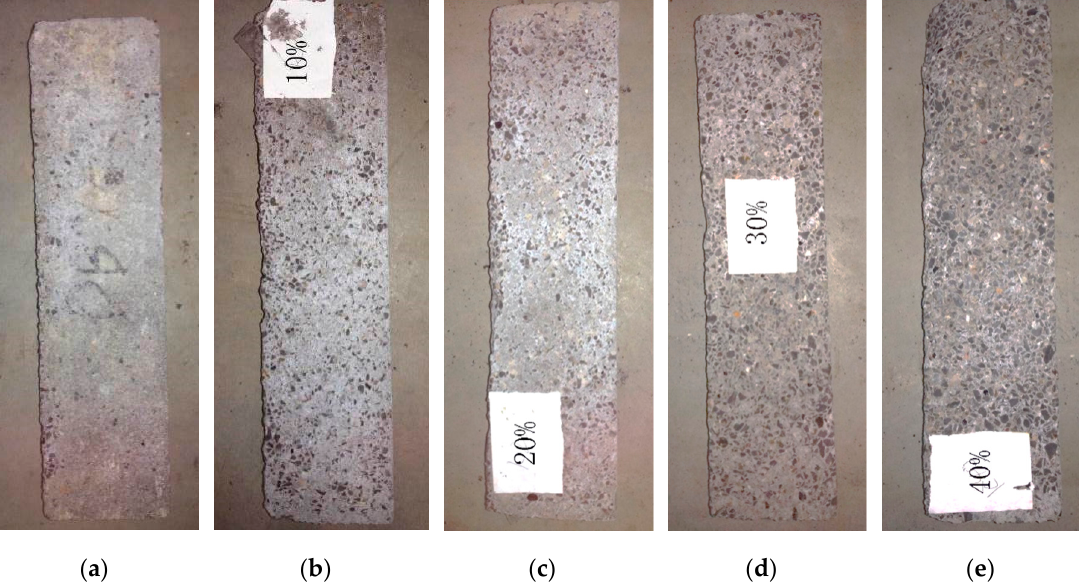
Figure 13. Surface damage of steel-fiber-reinforced CGAC after 500 F-T cycles, the cement substitution rates are: ( a ) 0%; ( b ) 10%; ( c ) 20%; ( d ) 30% and ( e ) 40%.